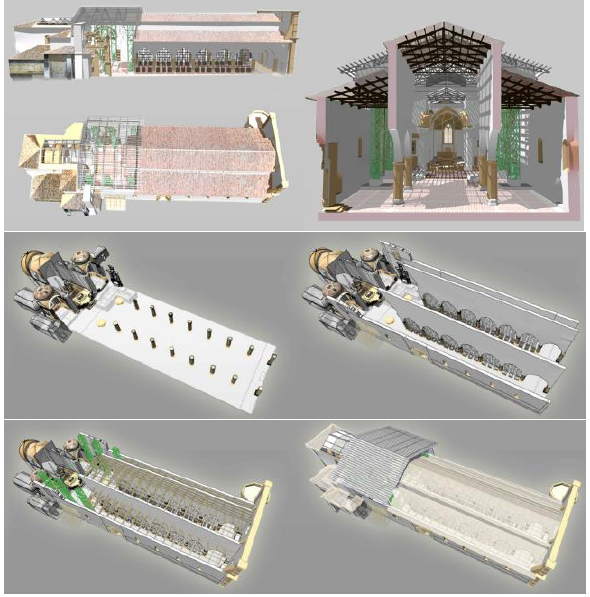
Figure 8. HBIM of the entire Basilica in ©Revit: solids from “free form” NURBS in